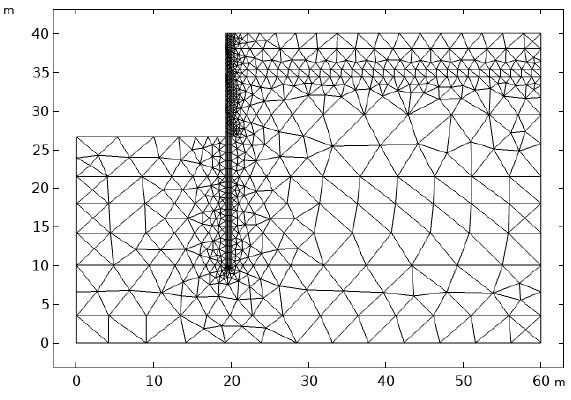
Figure 1. Model meshing diagram.